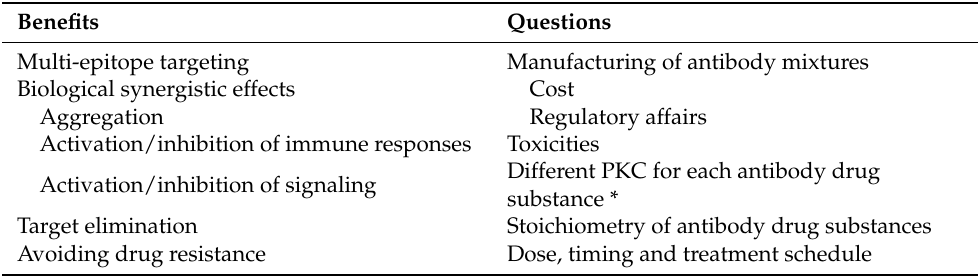
Table 3. Challenges of antibody